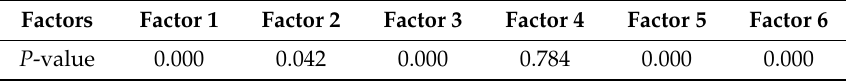
Table 7. The first logistic regression analysis results.